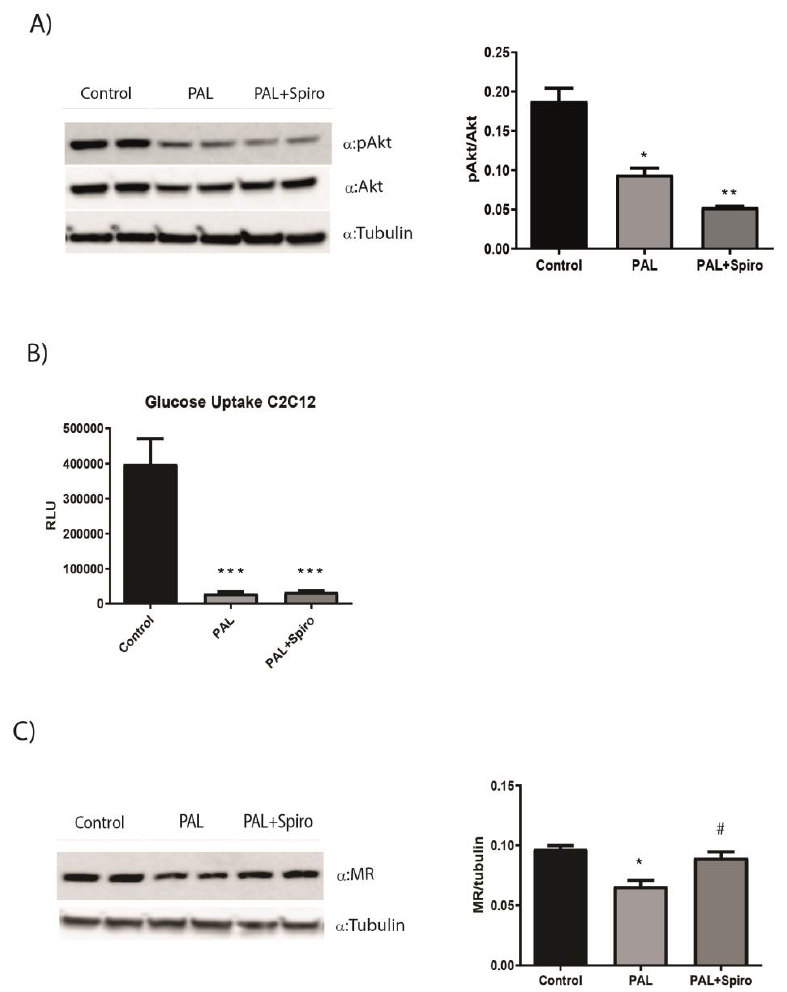
Figure 4. Spiro treatment does not improve insulin sensitivity in a model of insulin resistance in cultured murine myocytes ( A ), ( left panel ): representative immunoblots from 3 independent experiments for analysis of Akt activation in C2C12 myotubes treated with BSA/palmitate 0.75 mM and Spiro for 16 h and then stimulated with 100nM insulin for 15 min. ( Right panel ): distribution graphs of the densitometric scanning analyses performed by ImageQuant TL software by using α -tubulin as loading control. The phosphorylated form was normalized in comparison with its total form. ( B ), effect of Spiro on glucose uptake in C2C12 myotubes. Differentiated C2C12 myotubes were treated with BSA/palmitate 0.75 mM for 16 h in order to induce insulin resistance, in the presence or absence of Spiro. Glucose uptake in cells was determined using the Glucose Uptake-Glo Assay Kit (Promega). ( C ), representative immunoblots from 3 independent experiments for analysis of MR expression in C2C12 myotubes treated with BSA/palmitate 0.75 mM and Spiro for 16 h. ( Right panel ): distribution graphs of the densitometric scanning analyses performed by ImageQuant TL software by using α -tubulin as loading control. * p < 0.05 vs. control; ** p < 0.01 vs. control; *** p < 0.001 vs. control; # p < 0.05 vs. control. Values are expressed as means ±